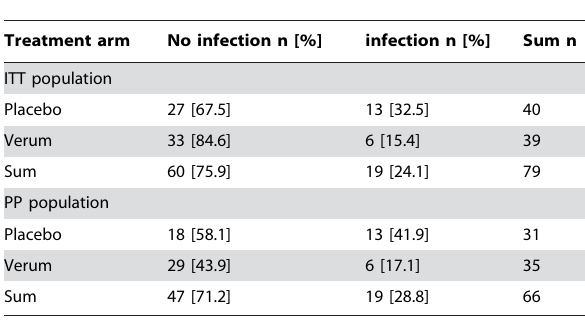
Table 2. Incidence of infections in ITT and PP population